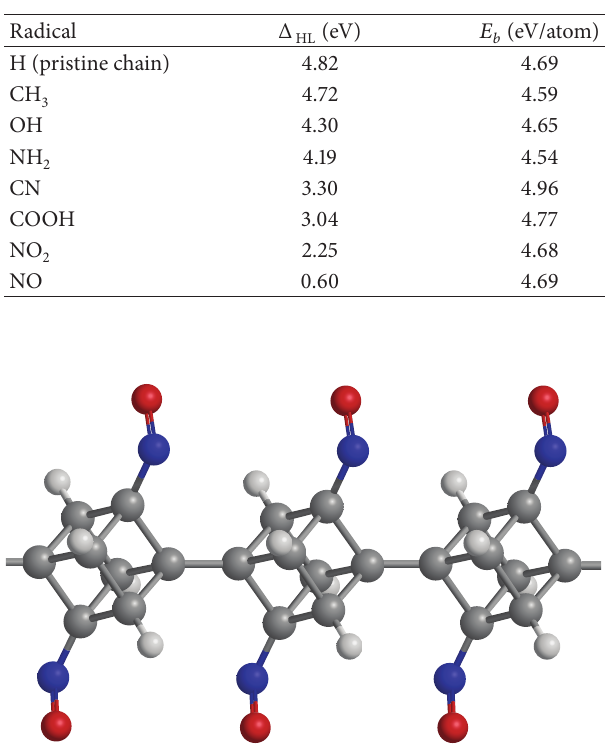
Figure 3: Fragment of the double NO-functionalized cubane-based